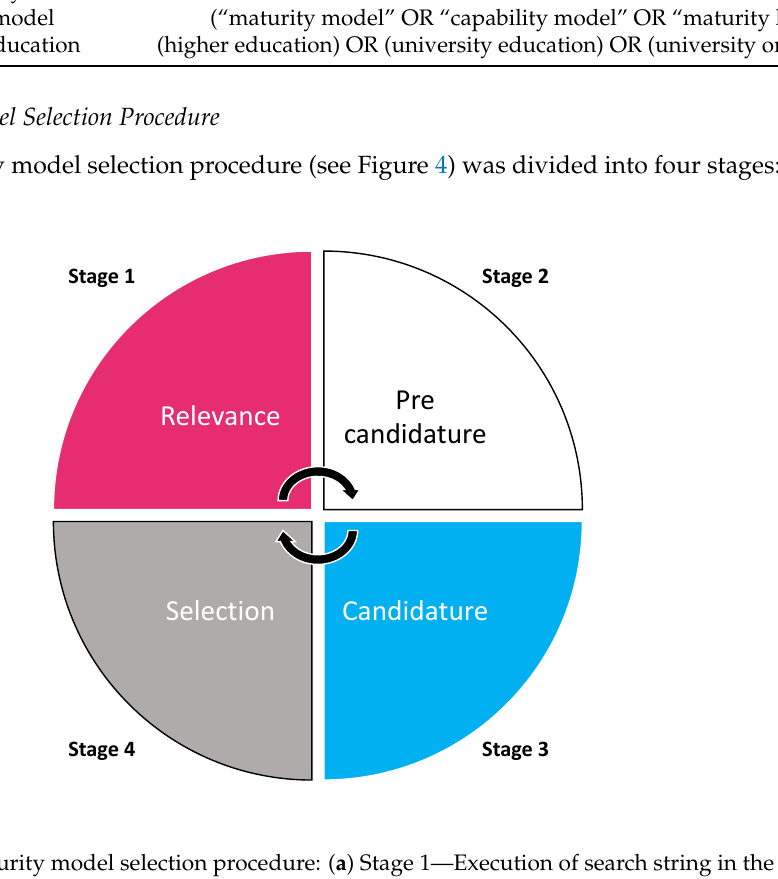
Figure 4. Maturity model selection procedure: ( a ) Stage 1—Execution of search string in the selected Databases; ( b ) Stage 2—Those who met conditions 1-i, 2-i and 4-i were considered